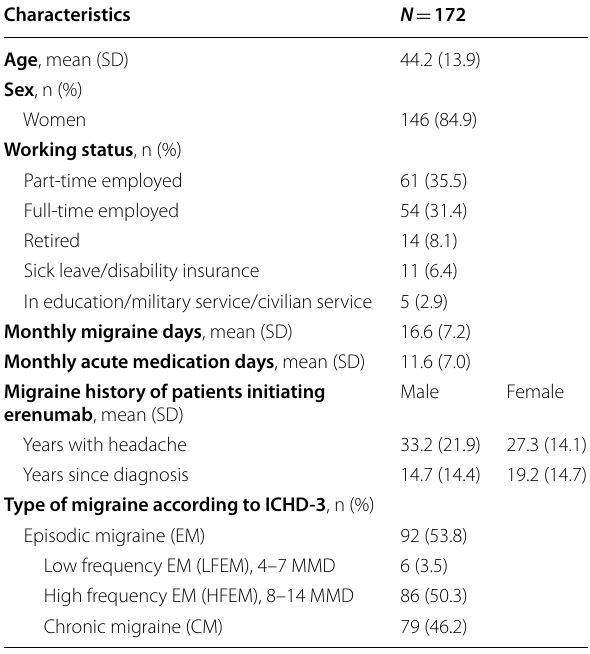
Table 1 Demographics and baseline characteristics, working status of study population, migraine type and